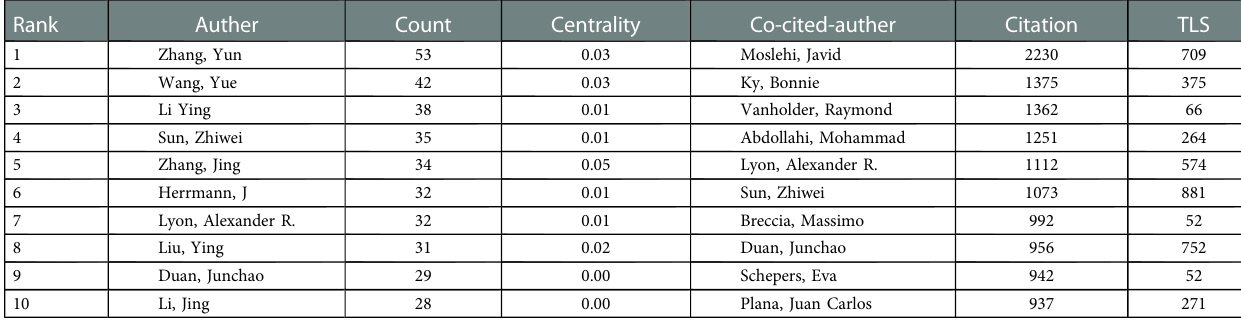
TABLE 3 The top 10 authors and co-cited authors of cardiotoxicity